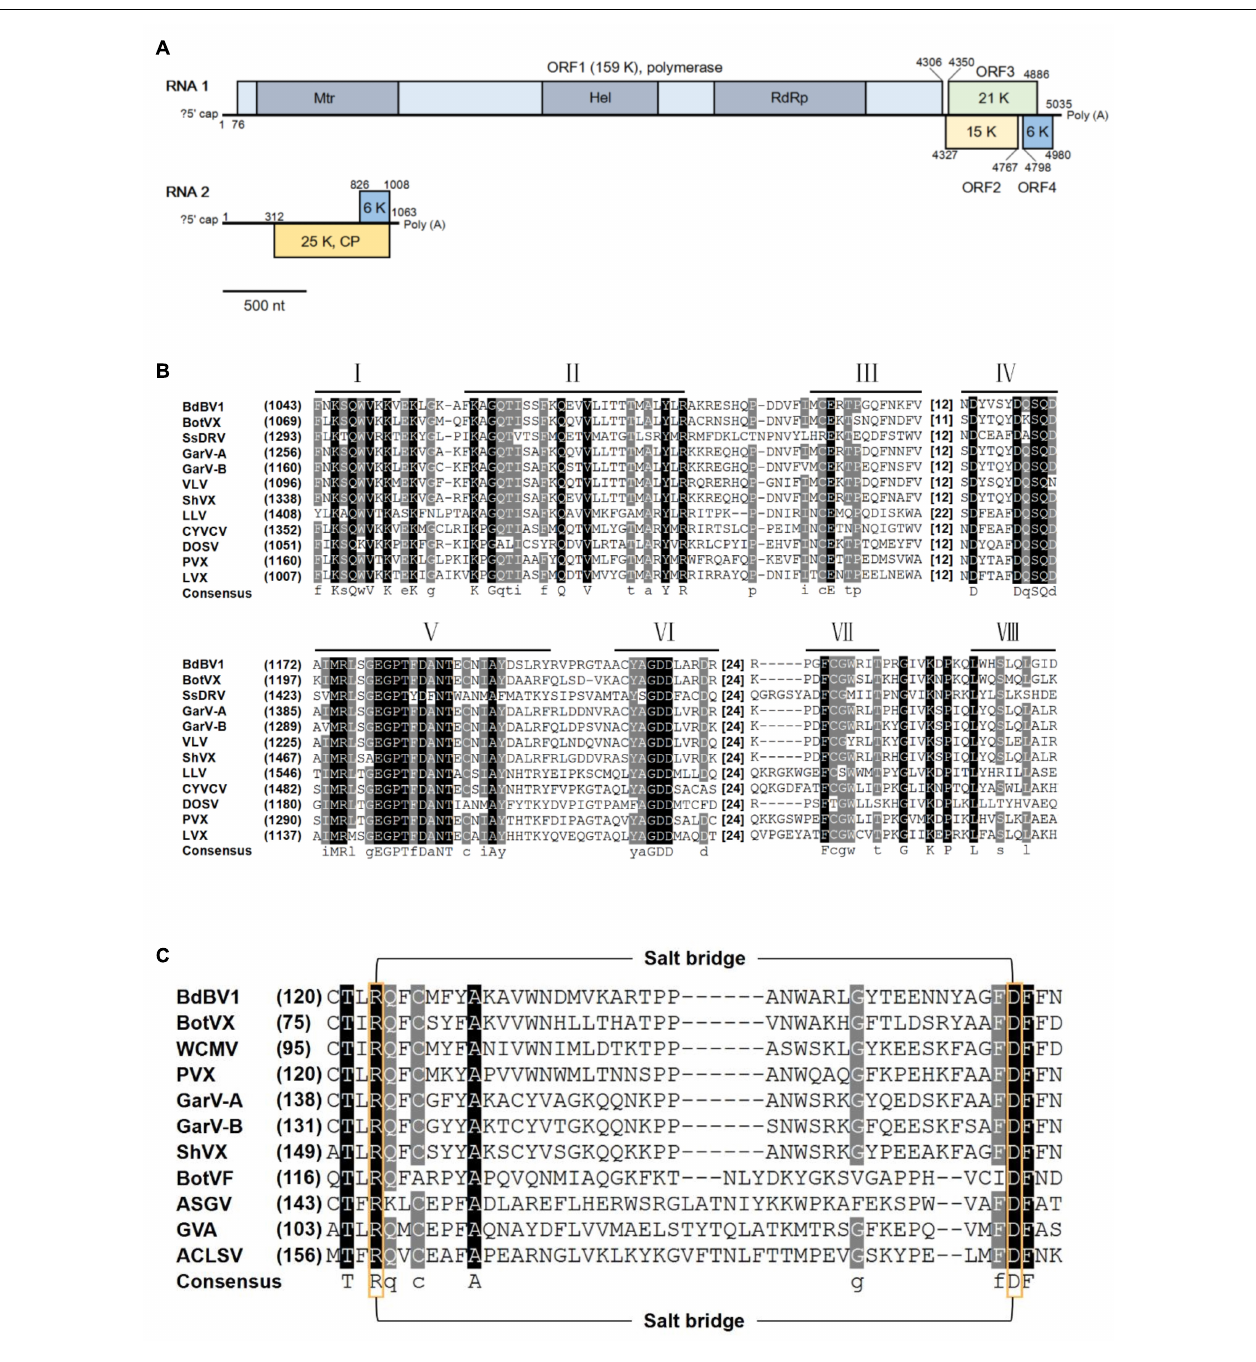
FIGURE 1 | Genomic properties of Botryosphaeria dothidea botrexvirus 1 (BdBV1). (A) Schematic representation of the genomic organization of BdBV1. Different proteins are represented by different colored boxes, three conserved domains in ORF1 are indicated by darker areas. (B) Multiple alignment of the region corresponding to RdRp domain of BdBV1 and other selected alphaflexiviruses. Eight core RdRp motifs are indicated with lines above. The starting amino acid (aa) position and spacing between motifs are indicated. (C) Multiple alignment of the CP aa sequences of BdBV1 and other flexuous rod-shaped viruses potentially involved in salt-bridge formation. The conserved positively (Arg) and negatively (Asp) charged residues are indicated by yellow boxes.